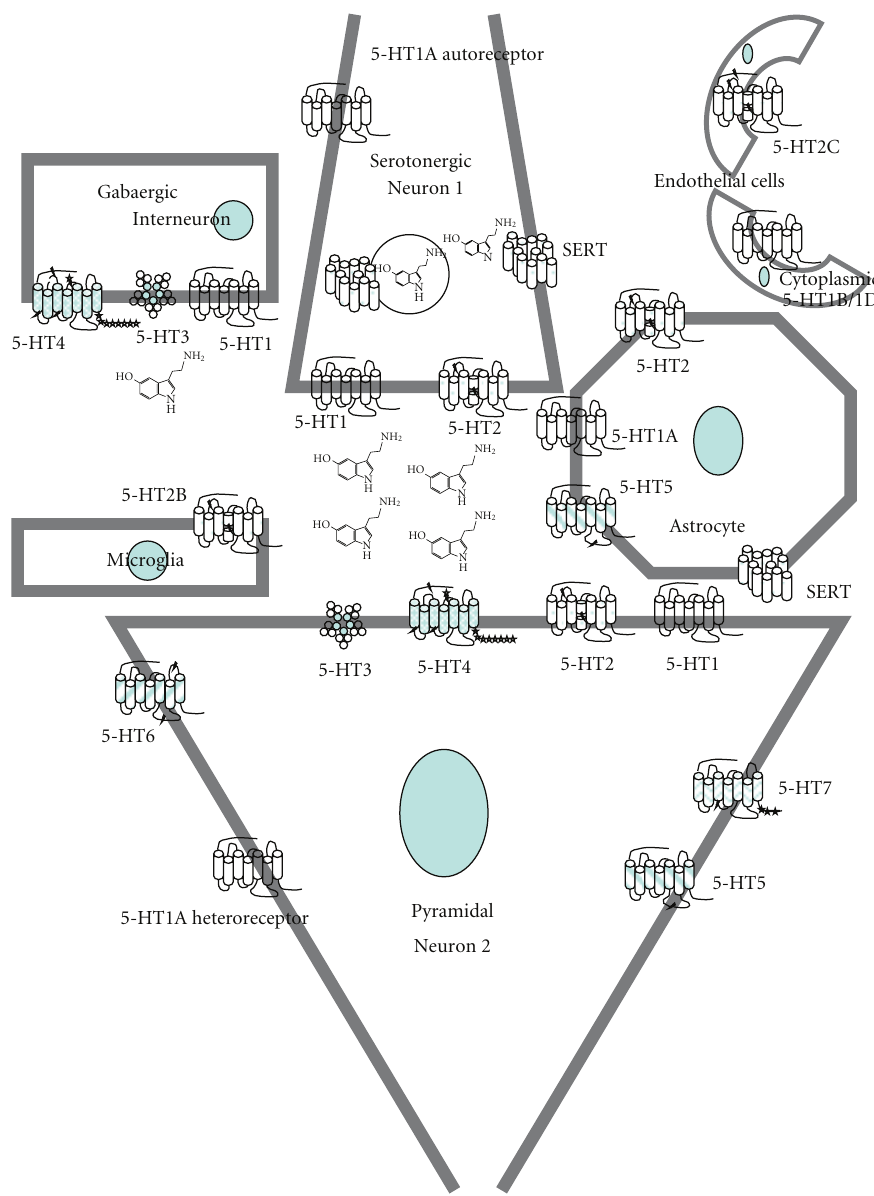
Figure 6: Serotonin receptors in hippocampus. The functional glia-neuron-vascular cells network uses several serotonin receptors (5-HTRs). The 7TMD images of each subtype receptor are represented with the defined number of exons that code for the mature protein (Bockaert et al., 2006) [44]; putative intron location in correspondent pre-mRNA is marked by a lightning symbol ( (cid:2) ); alternative splicing sites are marked with stars ( (cid:2)(cid:2)(cid:2) ). Neuron metabotropic 5-HTRs are mainly somatodendritic volume receptors although there is an association with synaptic specializations for some of them. 5-HT 3 with the five 4TMD subunits of a ligand activated ion channel is shown as synaptic receptor although this fact remains to be determined in hippocampus. Microglia is also included in the network for its relevance in pathophysiological responses, with 5-HT 2 B receptor expression (Capone et al., 2007) [90]. The 12TMD image of the serotonin transporter (SERT; 5-HTT) and vesicular monoamine transporter (VMAT) are represented in the serotonergic neuron and only SERT in the astrocyte.